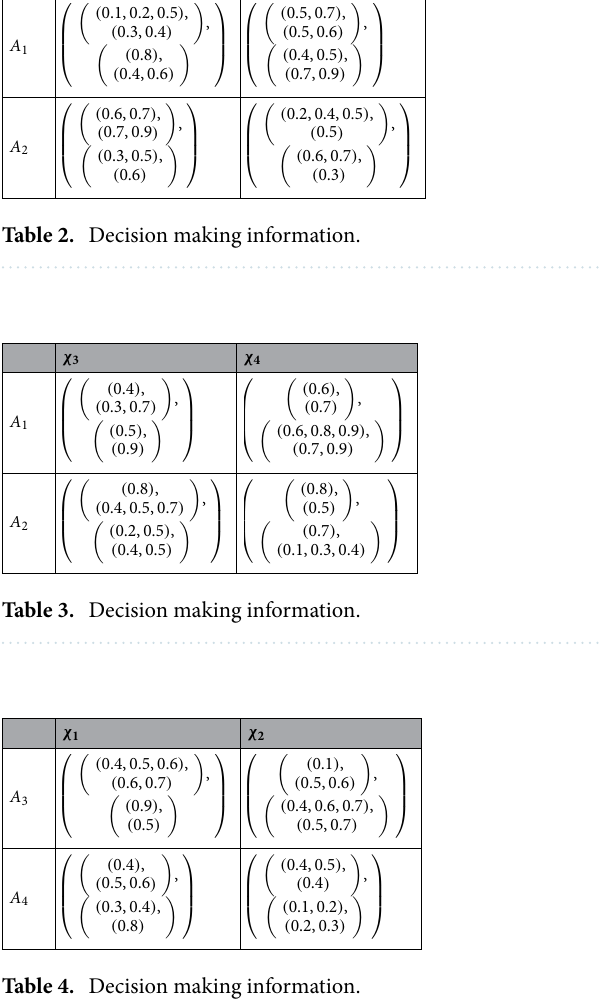
Table 4. Decision making